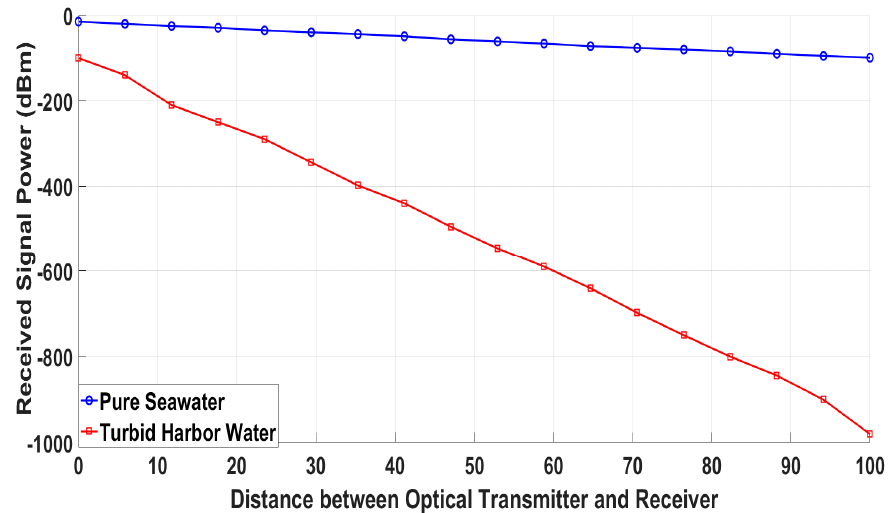
Figure 10. Signal power received by optical receiver against different distance value between diver and retroreflector.